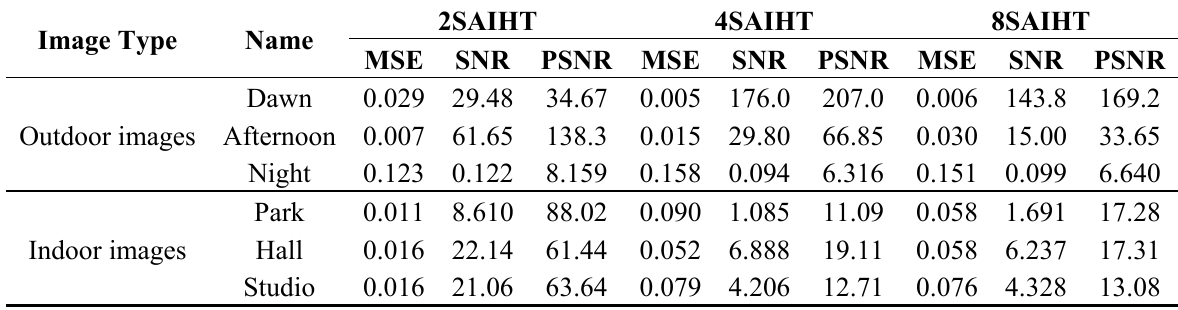
Table 4. Compare results of 2SAIHT, 3SAIHT, 4SAIHT and 8SAIHT methods using MSE, SNR and